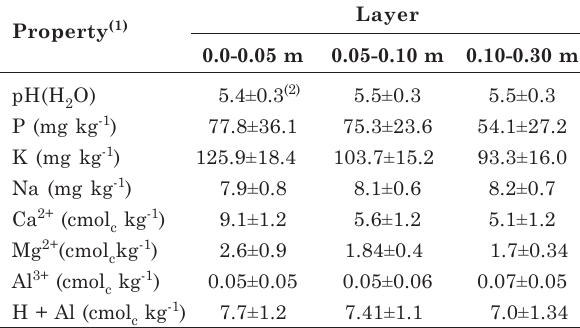
(1) Properties evaluated as proposed by Embrapa (1997). (2) Values corresponding to the mean and standard deviation of the samples in each layer (n = 24) in the study